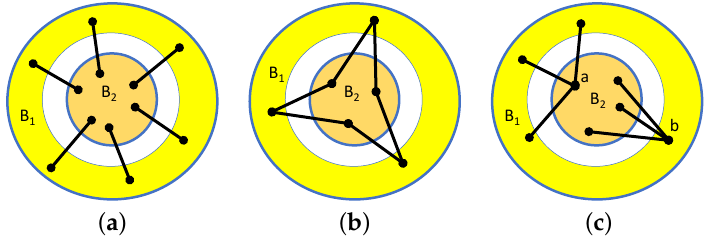
Figure 48. Two bodies can be linked in rigid ways ( a , b ) for almost all choices of the points and in ways that are never infinitesimally rigid ( c